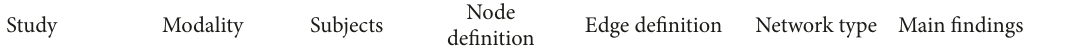
Table 4: Overview of structural brain network studies in